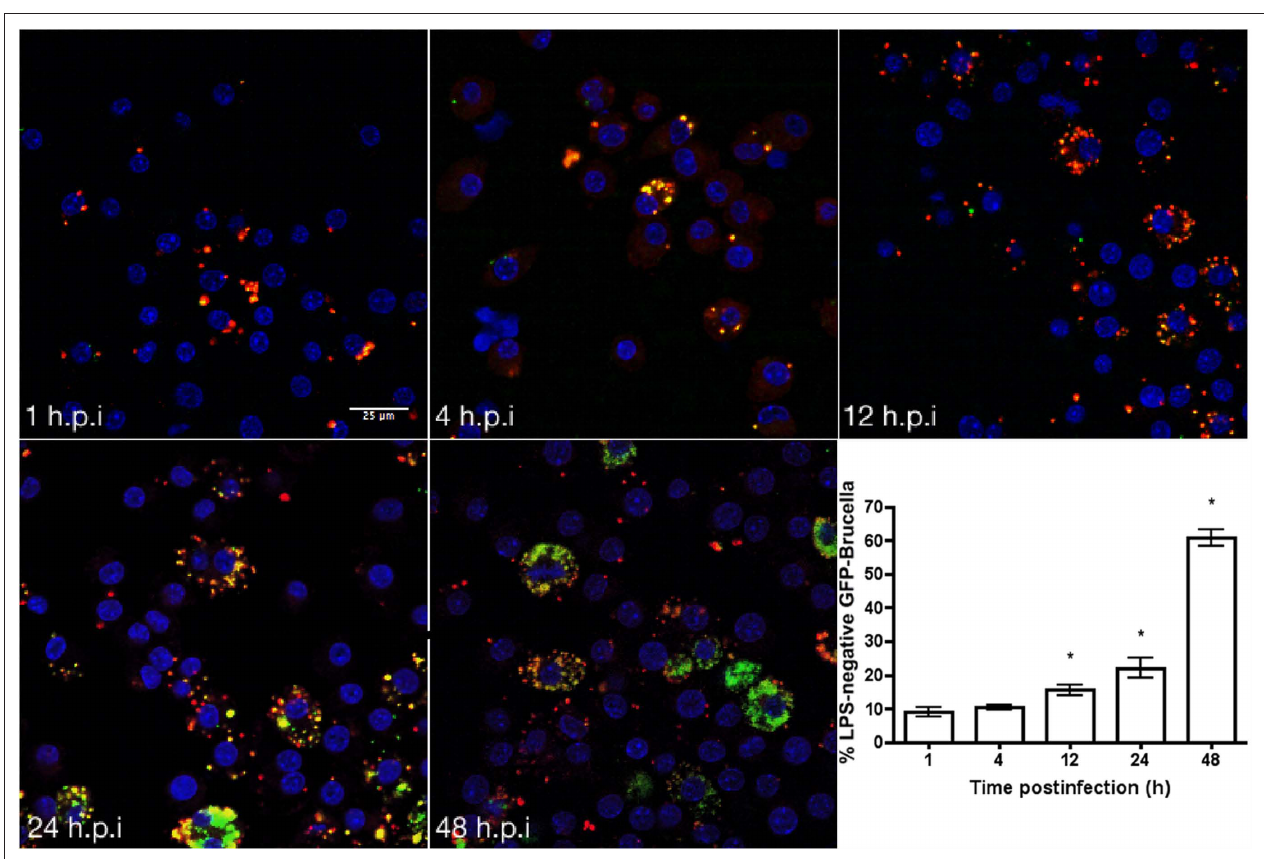
FiguRE 3 | Spontaneous loss of O-polysaccharide reactivity among Brucella organism growing in macrophages ex vivo . Macrophages were infected with smooth B. melitensis 16M and in vitro loss of Brucella LPS was monitored using primary mouse anti- Brucella over a 48-h time period. Presence of bacteria either expressing smooth LPS (yellow, colocalized signal) or rough